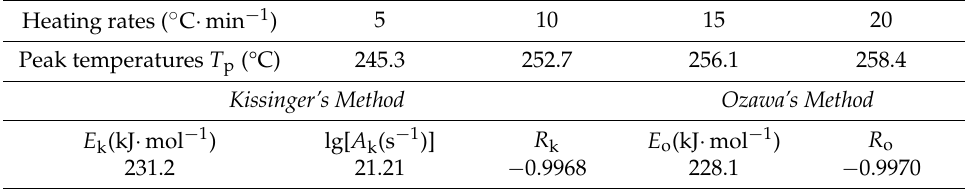
Table 4. Peak temperatures and non ‐ isothermal kinetic parameters of 2(SCZ) ∙ BTO.